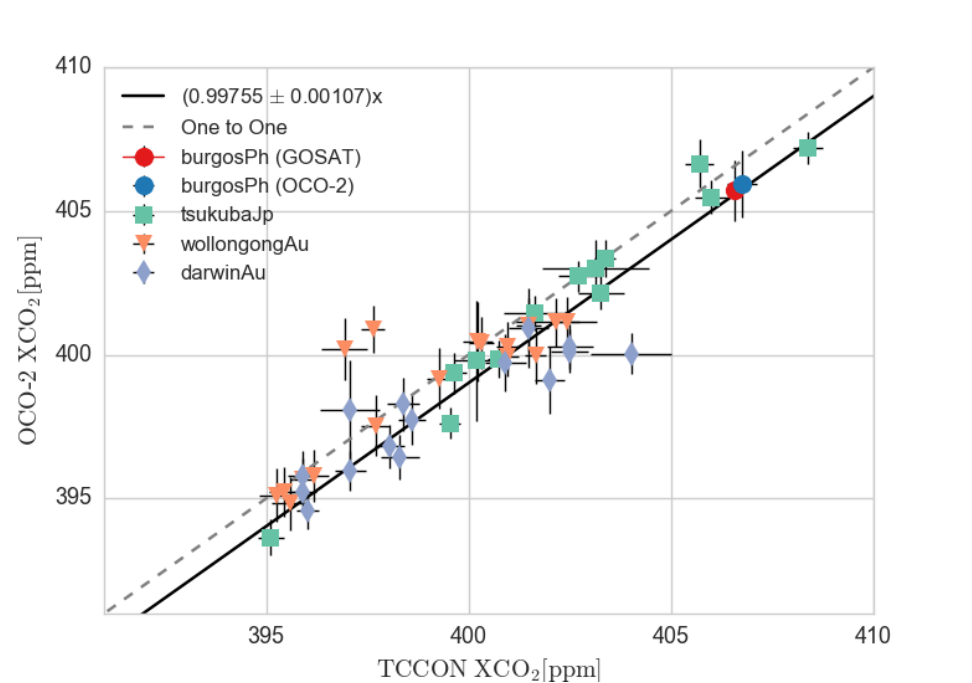
Figure 2. Target mode X CO retrievals from the OCO-2 satellite vs. X CO from TCCON stations. Only 2 2 stations in Tsukuba, Wollongong, Darwin and Burgos are shown for clarity. The calibration line (solid black line) is derived from all TCCON sites. The most recent GOSAT sounding (red circle) is also added on this plot, but not included in the calculation of the calibration curve. It falls within 0.13 ppm of the OCO-2 calibration line. The two outliers in the OCO-2 measurements over Wollongong (downward triangles) are probably due to bias induced by stratospheric aerosols caused by the eruption of the Calbuco volcano on 22 April 2015